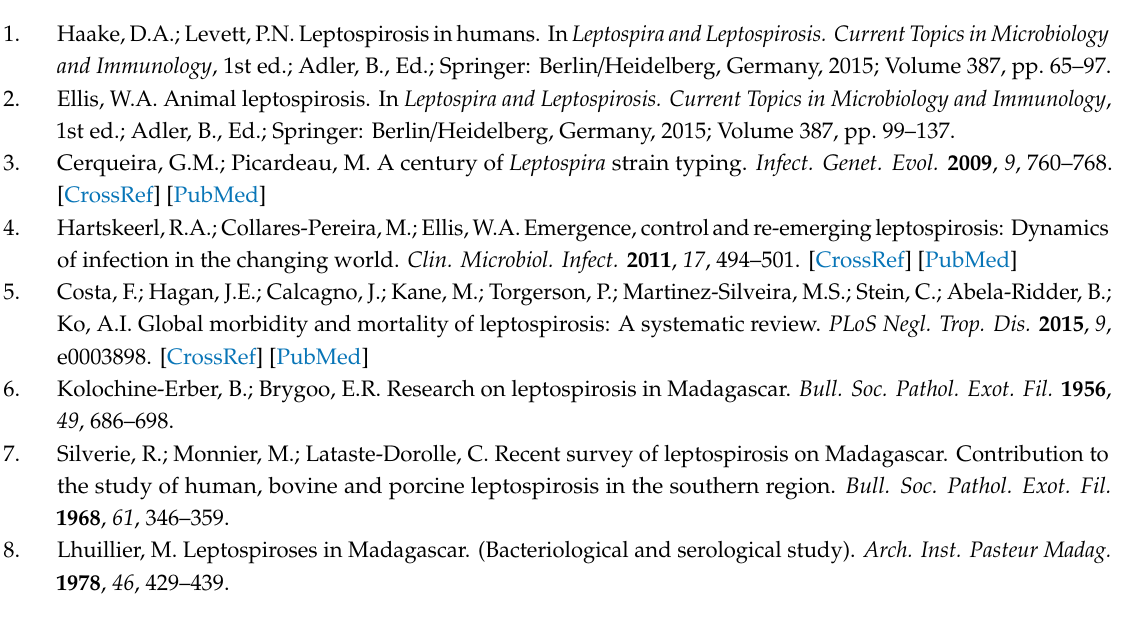
Table S1: Seroprevalence of each serovar according to geographic sampling region. Table S2: Number of individuals and relative prevalence per Leptospira spp.